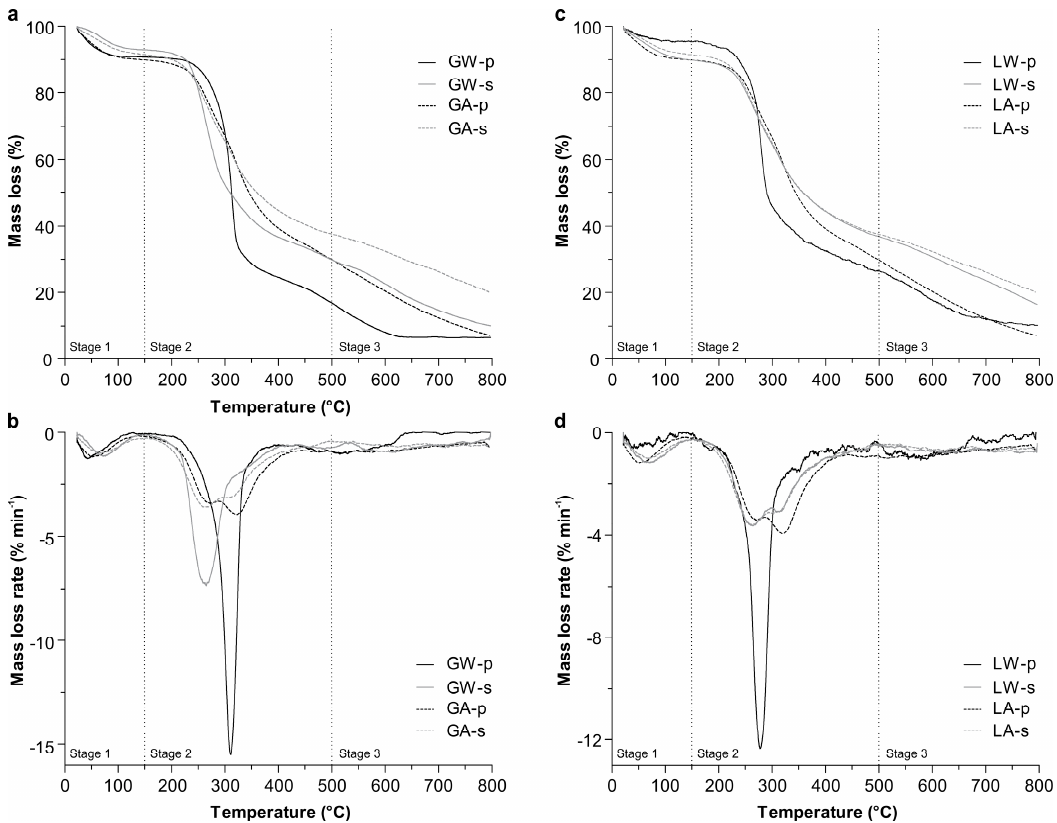
Figure 2. Thermogravimetric ( a , c ) and derivative thermogravimetric curves ( b , d ) of aqueous and alkaline fractions from P. gyrans (GW-p, GW-s, GA-p, GA-s) and P. lutheri (LW-p, LW-s, LA-p, LA-s) at a heating rate of 10 °C ⋅ min − 1 under a nitrogen atmosphere.